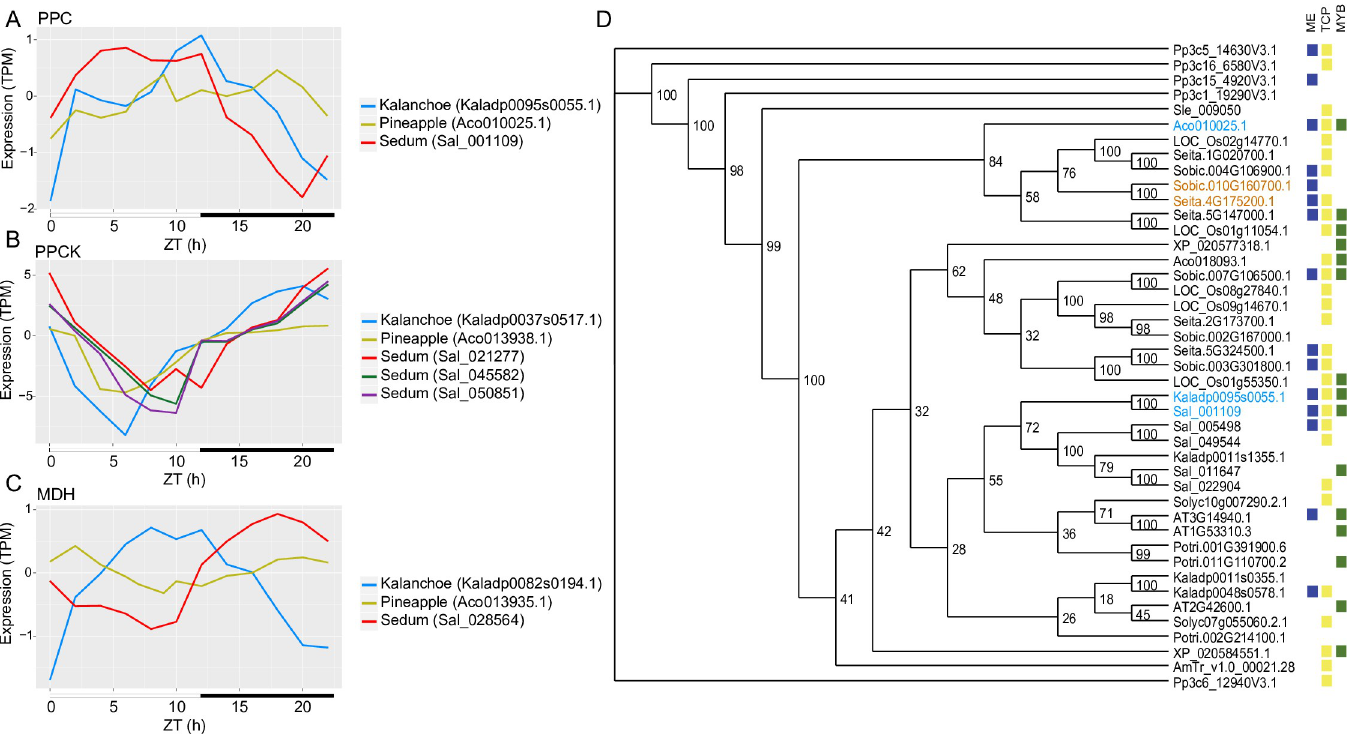
Fig 6. Conserved transcript expression of core CAM genes and recruitment of PPC during CAM evolution. (A-C) Transcript expression of PPC , PPCK and MDH genes in S . album , A . comosus and K . fedtschenkoi are plotted. (D) Maximum likelihood phylogenetic tree of PPC orthologs in 10 species. The bootstrap support values are indicated on each node. The PPC copies used by CAM and C4 plants are highlighted in blue and orange, respectively. Clock associated cis -elements located in the 2kb upstream promoter of PPC are denoted in blue (morning element, ME), yellow (TCP transcription factor), and green (MYB transcription